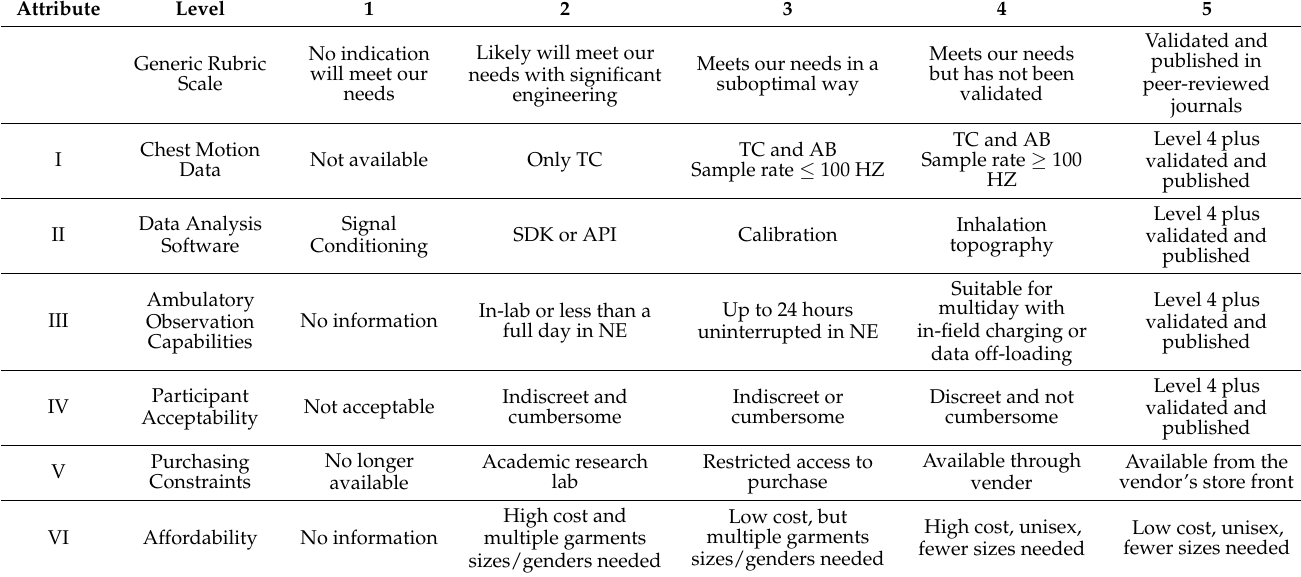
Table 1. Scoring rubric used to evaluate products relative to each of the six assessment